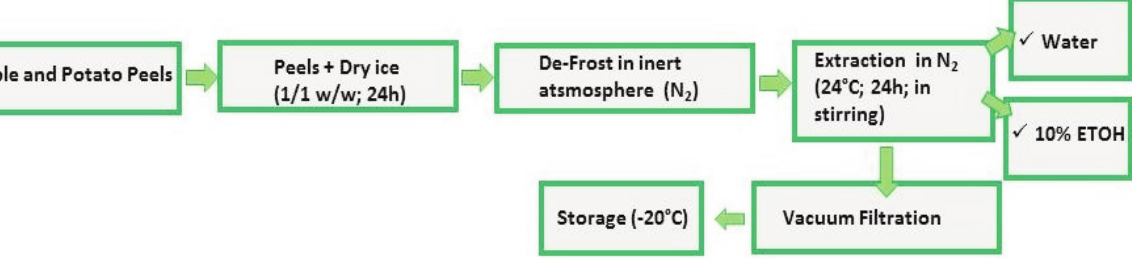
Fig. 2 ­ Procedure applied to obtain apple and potato extracts using as solvent water and 10% ethanol. Both extracts were stored at ­ 20°C before